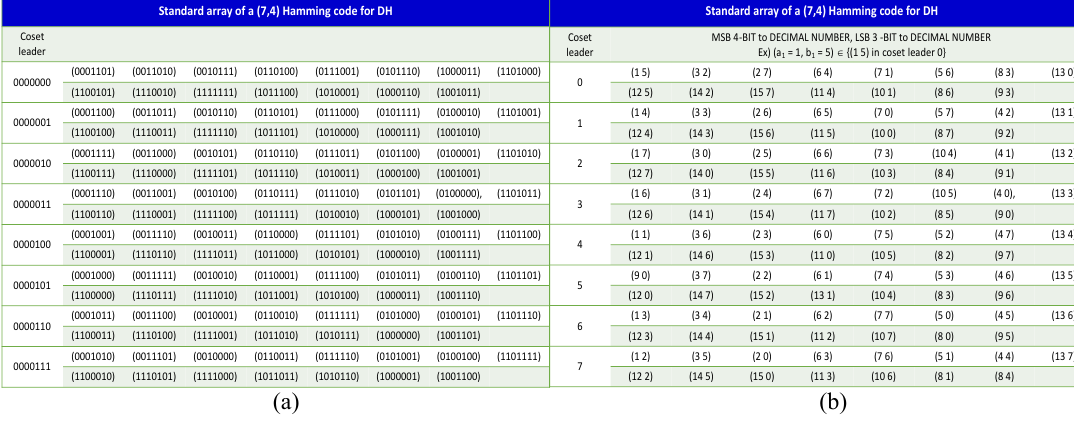
Figure 3. Standard array of HC(7,4) for Data Hiding (DH): ( a ) binary presentation and ( b ) decimal